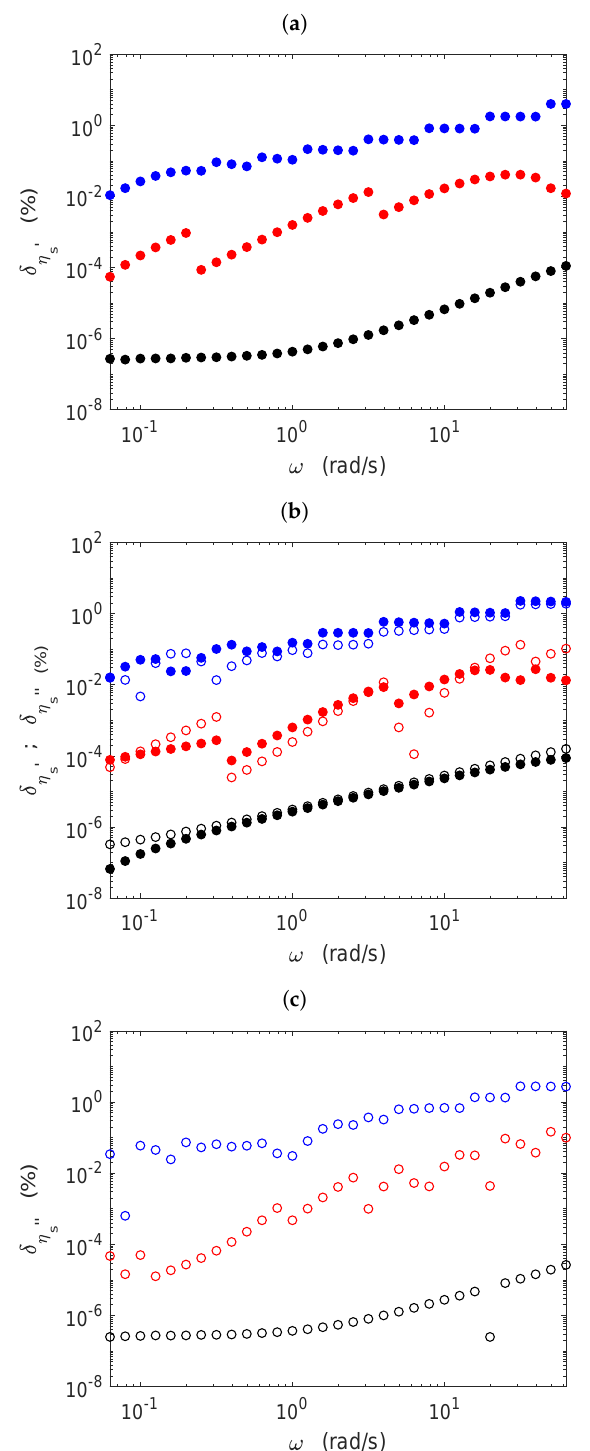
Figure 4. Relative errors obtained in the non-null components of the complex interfacial viscosity as a function of frequency for: ( a ) purely-viscous interfaces, ( b ) viscoelastic interfaces, and ( c ) purely-elastic interfaces. Filled and empty circles refer to the real and imaginary parts of the complex interfacial viscosity, respectively. Symbols’ colors indicate the numerical value of η s , namely η s = 10 − 2 (black), η s = 10 − 4 (red), and η s = 10 − 6 (blue), in units of N